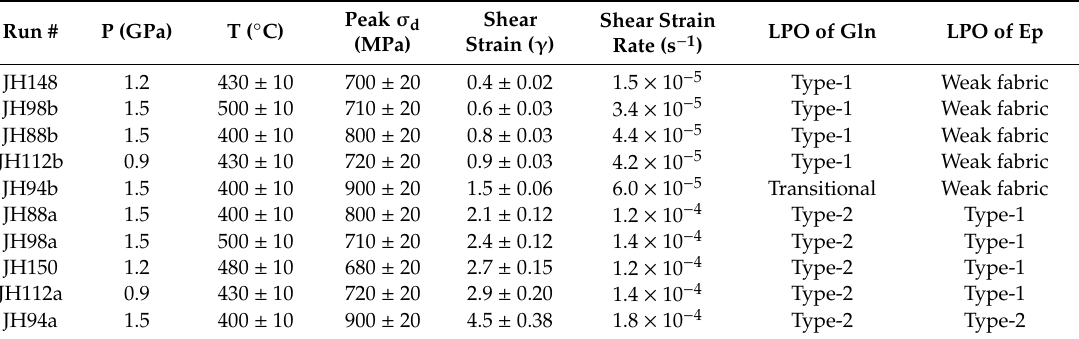
Table 2. Experimental conditions and results for the deformation experiment on epidote